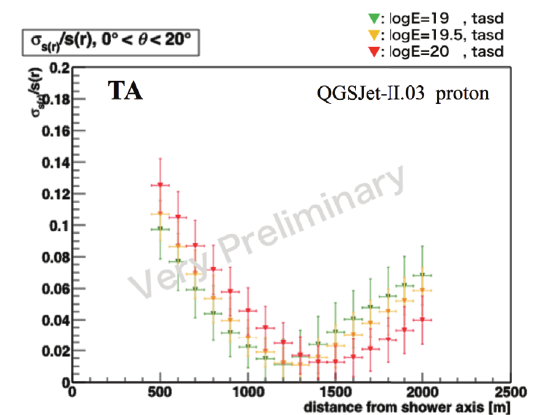
Figure 6. Fluctuations of the signal estimated with the TA LDF arising from the uncertainty in the slope